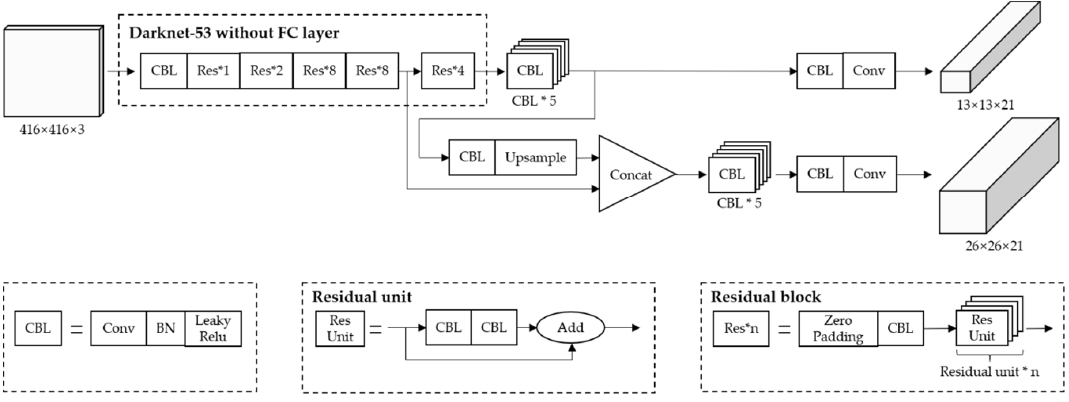
Figure 3. New improved Yolov3 network architecture.